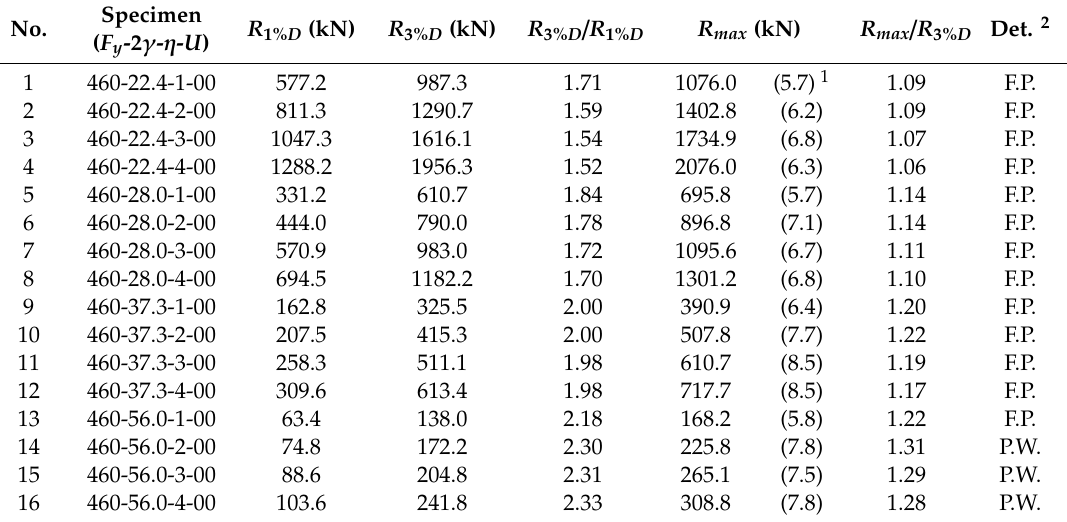
Table 8. Parametric analysis results of HSB600 ( F y = 460 MPa).